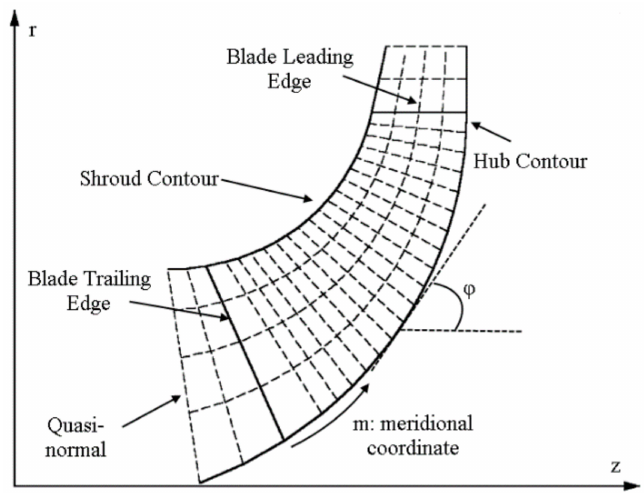
Figure 6. Gas path design system used for the rotor blade detailed